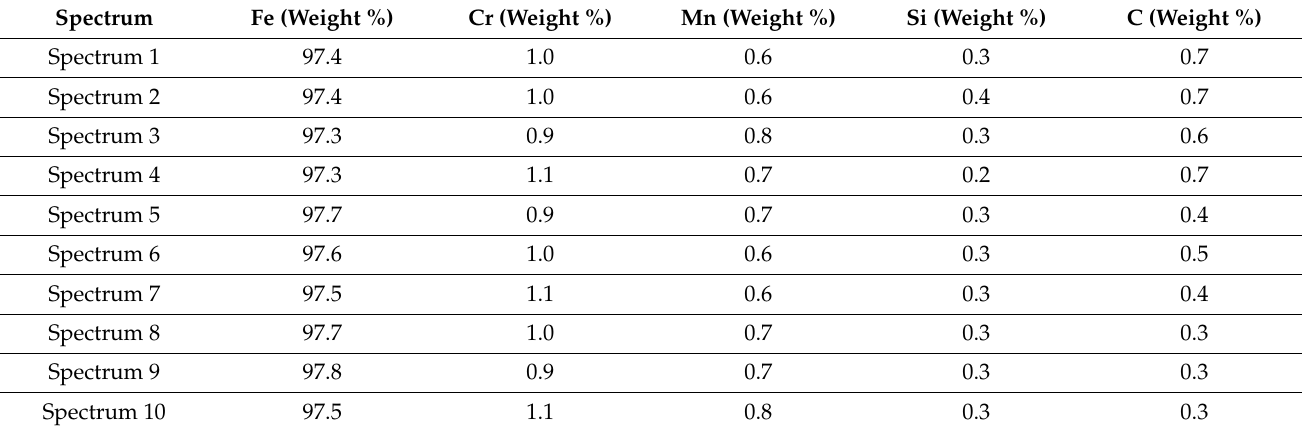
Table 3. EDS analysis results.